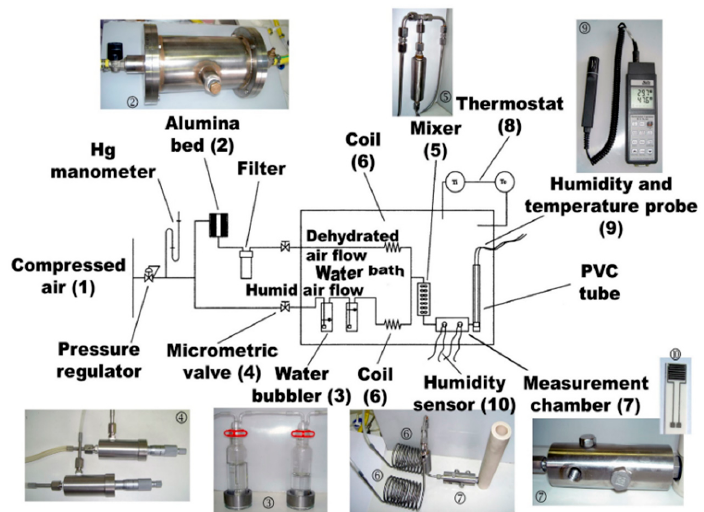
Figure 3. RH measurement system used in dynamic tests [33].